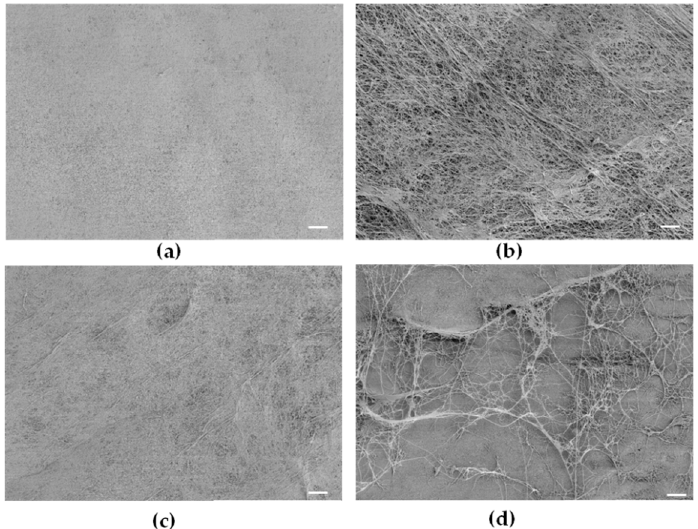
Figure 2. Scanning electron microscopy of never-dried biocellulose tubes synthesized by MMR Tech from Komagataeibacter xylinus DSM 32384 (magnification: 600x, scale bars: 10 µm). ( a ) Outer surface of biocellulose tube V1 directed to the air space; ( b ) luminal surface of biocellulose tube V1 directed to template; ( c ) outer surface of a manually inverted biocellulose tube V3; ( d ) luminal surface of a manually inverted biocellulose tube V3.